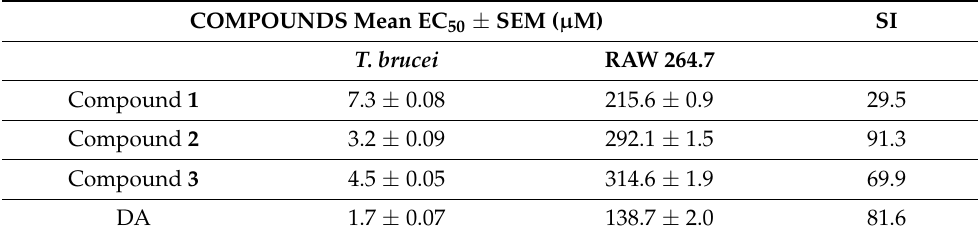
Table 2. Antitrypanosomal potencies and selectivity indices of compounds.